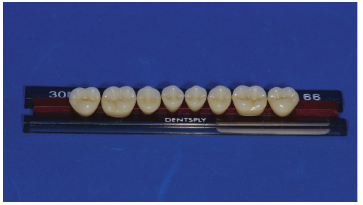
Figure 2: Biotone artificial